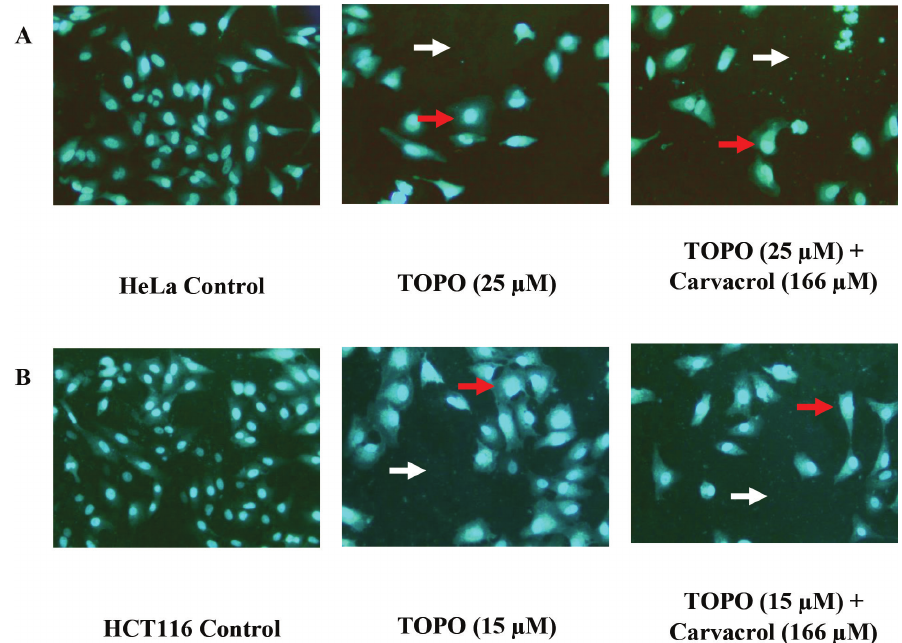
Figure 5. Fluorescent microscopy images (Scale bar: 20 µm) of A) HeLa and B) HCT116 cell lines treated for 24 h with TOPO IC in the absence or presence of carvacrol (166 µM). Images were magnified at 20×. The red, and white arrows represented nuclear enlargement or irregular shape, and intercellular space increase, respectively. Images were taken from at least three independent experiments with similar